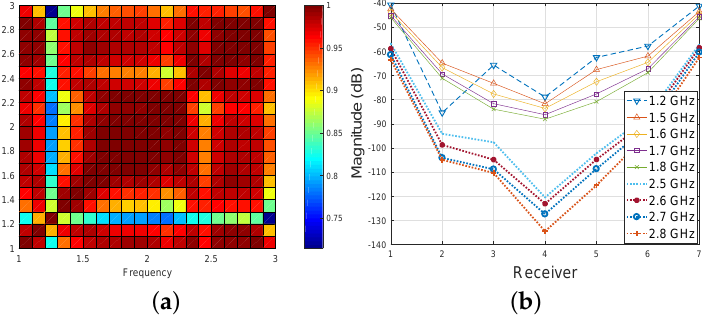
Figure 6. ( a ) Average cross-correlation map in Equation (9) using 3-D CST data in 90% corn syrup (the dataset in Figure 2c,d); ( b ) Example of amplitude plots for Transmitter 1 in two “sub-bands” of highly-correlated data selected from the map in ( a ), and how they differ from an “outlier” at 1.2 GHz.